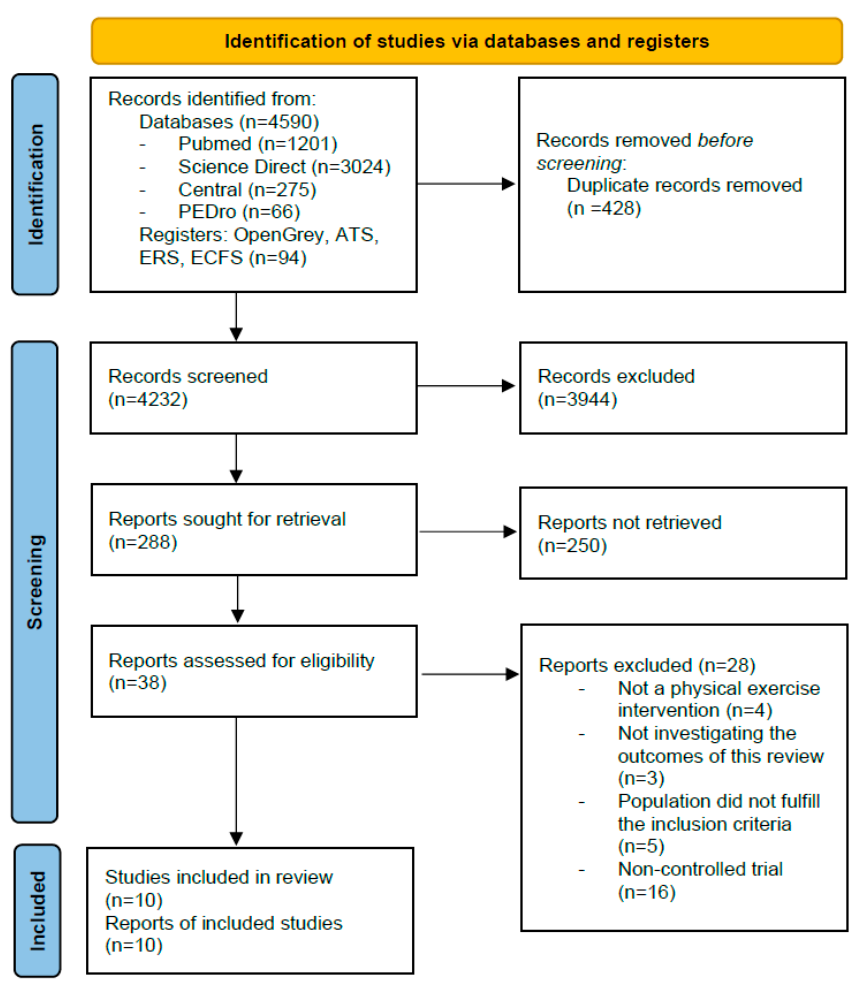
Figure 1. Flow diagram of the included studies.